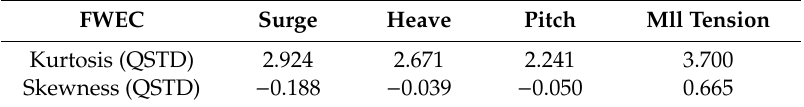
Figure 9. Normalized PDFs with the three models in surge (a) , heave (b) , pitch (c), and the most loaded line tension (d). Table 4. Mean obtained kurtosis and skewness of the FWEC motions and tension of the most loaded line, obtained with the QSTD approach. FWEC Surge Heave Pitch Mll Tension Kurtosis (QSTD) 2.924